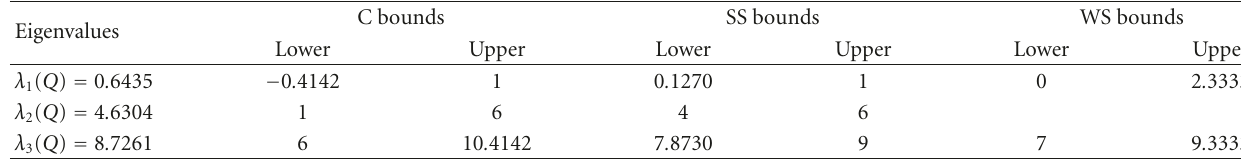
Table 2: C bounds, SS bounds, and WS bounds for Example 21.